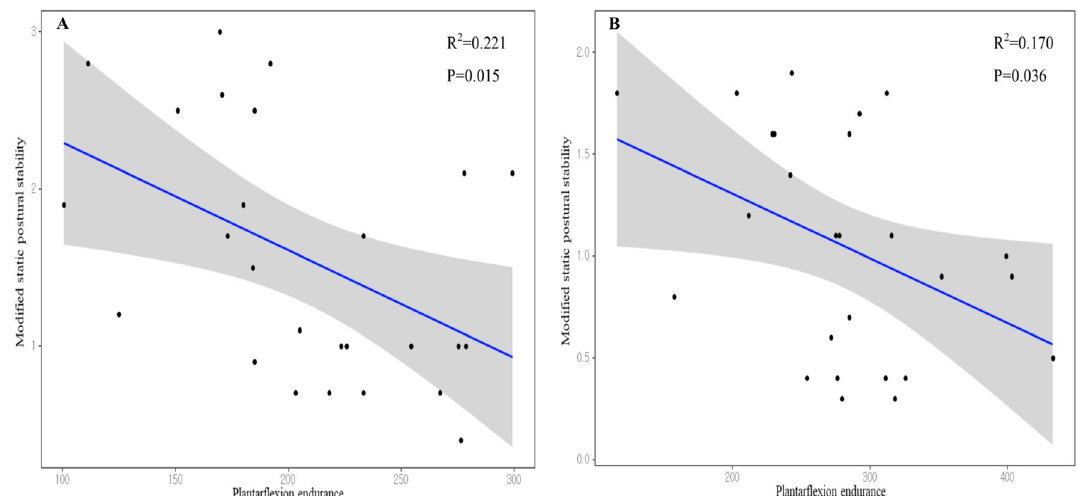
Figure 2. Plots show correlations between the modified static postural stability and plantarflexion endurance in CAI group ( a ) and healthy control group ( b